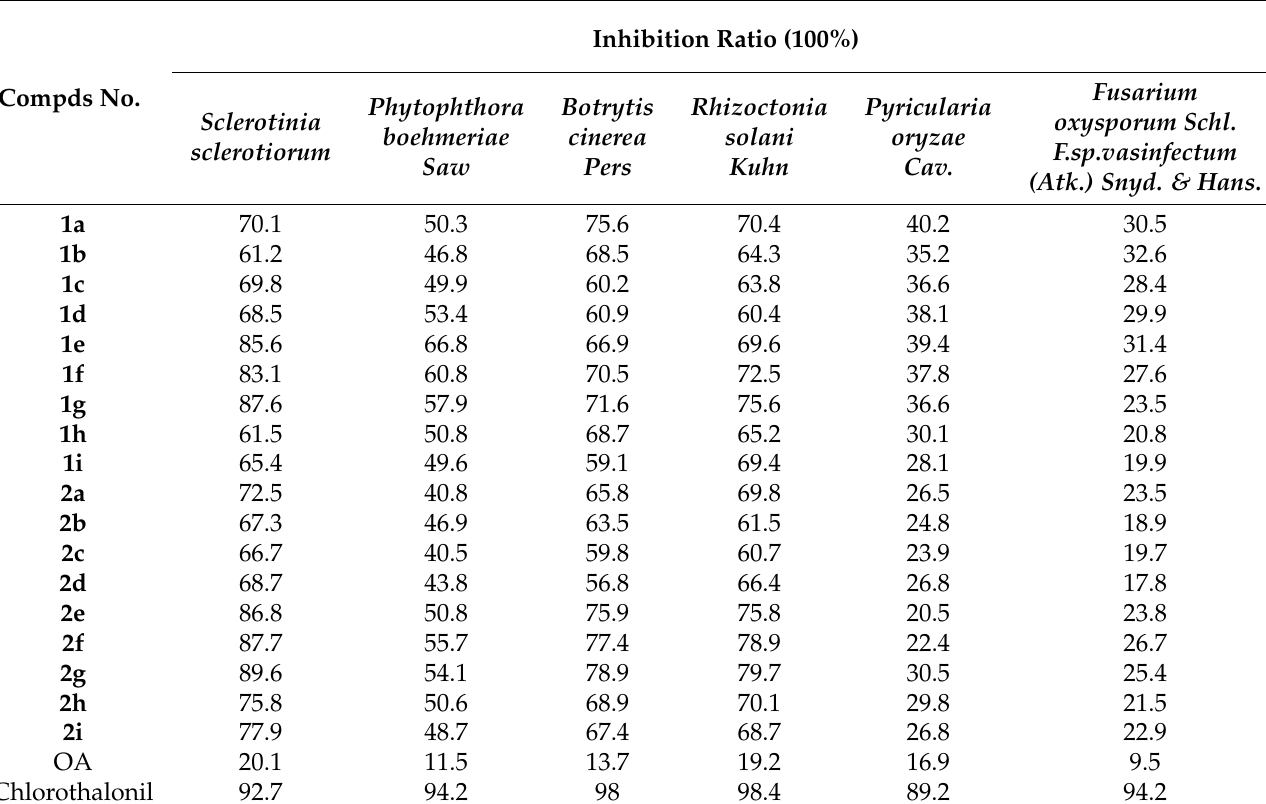
Table 2. Inhibition rate of target compounds against six fungus species (% control at 50 µ